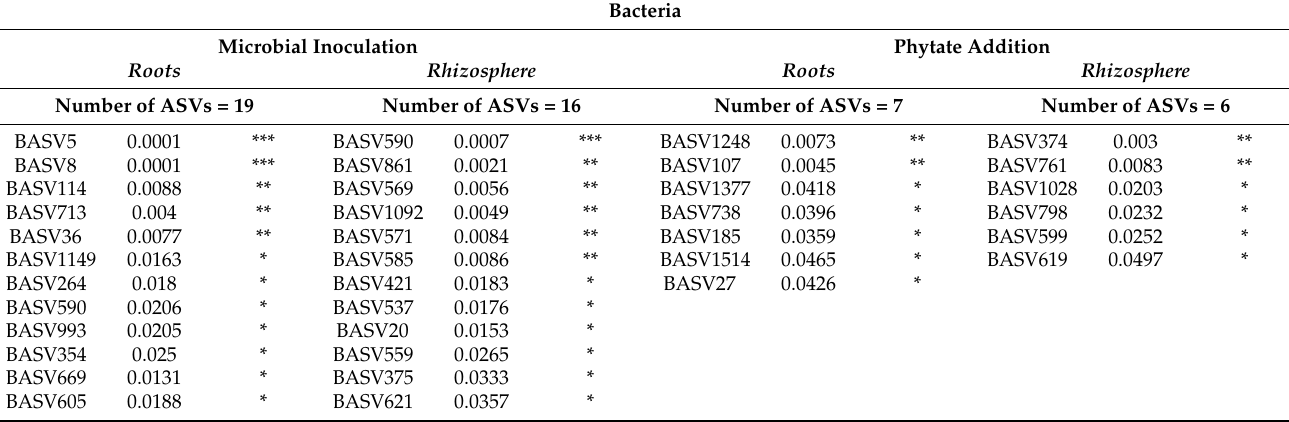
Table 3. List of bacterial and fungal ASVs selected under the inoculation and phytate addition treatments according to indicator species analysis. Significant selection at Sidak α = 0.0001, *** significant at α = 0.001, ** significant at α = 0.01, * significant at α =